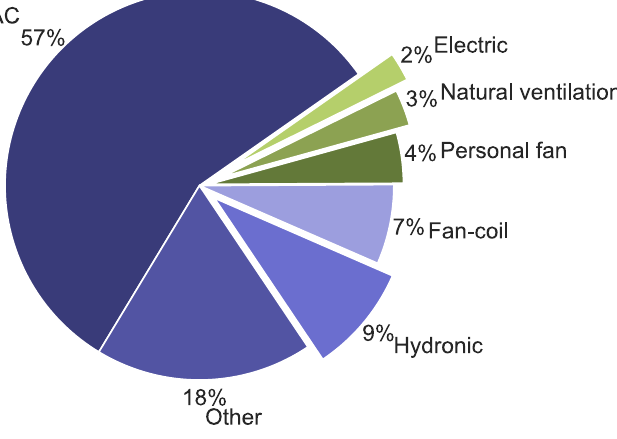
Figure 12. HVAC systems in the analyzed papers. Table 9. Hydronic heating (H) and/or cooling (C) systems in the analyzed